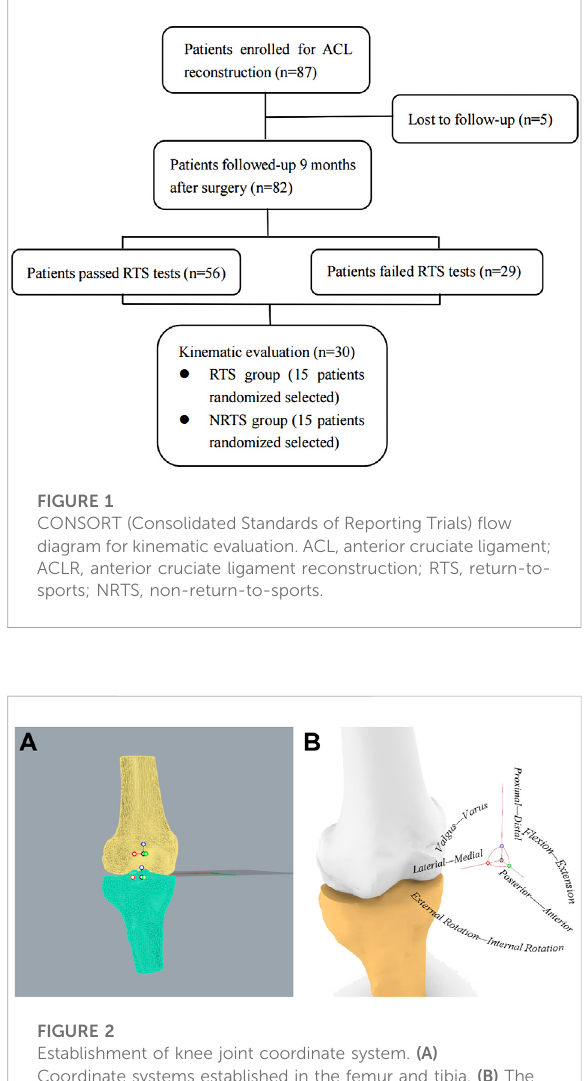
FIGURE 2 Establishment of knee joint coordinate system. (A) Coordinate systems established in the femur and tibia. (B) The relationship between the knee joint coordinate system and the kinematics of six degrees of